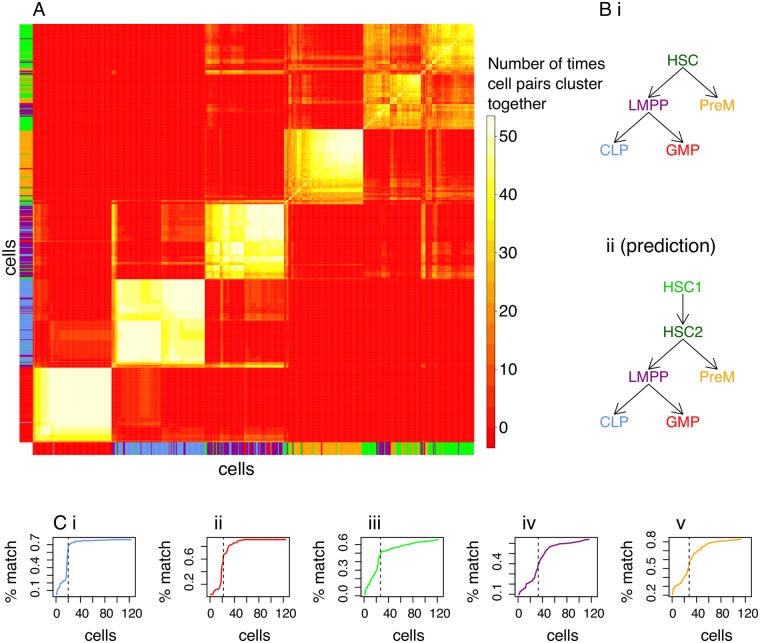
Application of SABEC to hematopoietic stem cells and progenitor populations.SABEC was used to identify subpopulations of cells in the Moignard et al. dataset and to identify specific cells that do not cluster well with the other cells of the same type. (A) Hierarchical clustering was applied to the SABEC consensus matrix to reveal six subpopulations of HSC in subfigure. (Bi) The expected hematopoiesis differentiation tree is shown–the names of the cell populations are color-coded to match the vertical and horizontal bars in A. (Bii) We hypothesized a possible alternative differentiation tree, based on the clustering results. (C) Another application of this clustering method is to remove possible outliers, which may have arisen due to poorly sorted cells or extrinsic variability. Within each cell population (i.e. CLP (i), GMP (ii), HSC (iii), LMPP (iv) and PreM (v)), we sorted the cells by how often the cells are clustered with other cells from the same FACS label (% match). The vertical lines depict thresholds selected to approximately correspond to the region with the steepest slope– cells to the left are disregarded as outliers in the EPiK analysis.